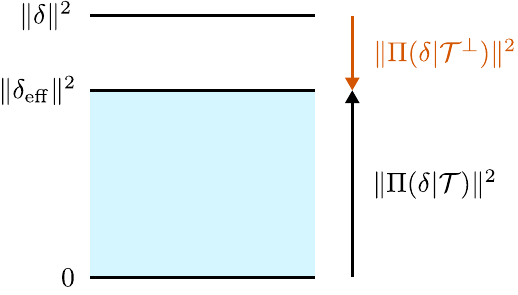
FIG. 7. An illustration of the conventional bottom-up approach to quantum bounds and the top-down approach to semiparametric bounds, as discussed in Sec. V